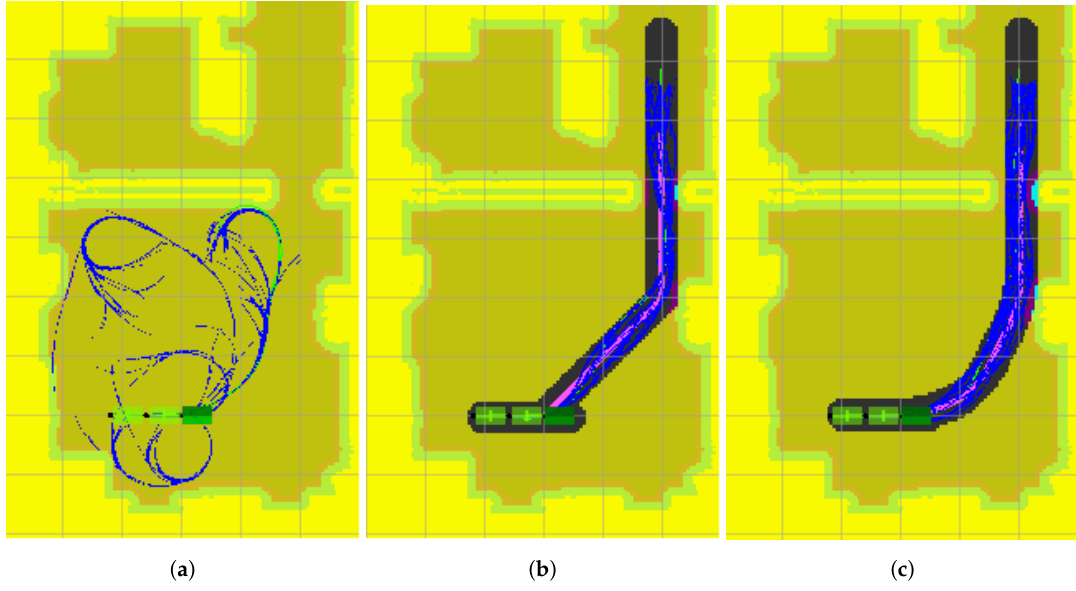
Figure 13. Goal 1 results. A small portion of total map (Figure 12) is presented. ( a ) Using RRT*; ( b ) Using ARA*-RRT*; ( c ) Using